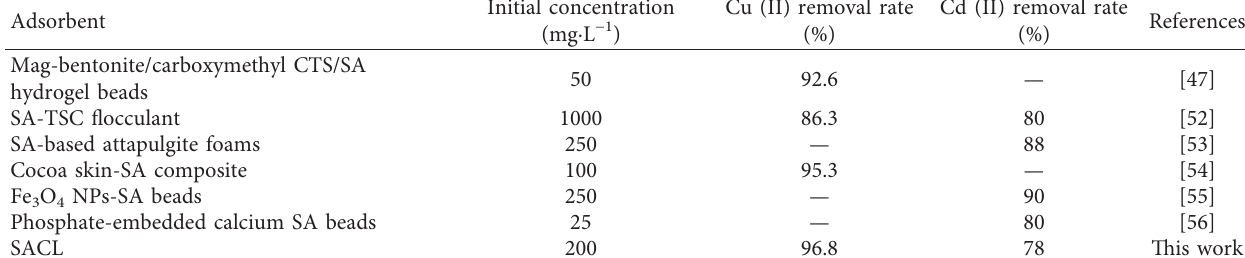
Table 7: Adsorption of Cu (II) and Cd (II) by SACL compared with the previously reported composite materials. Adsorbent